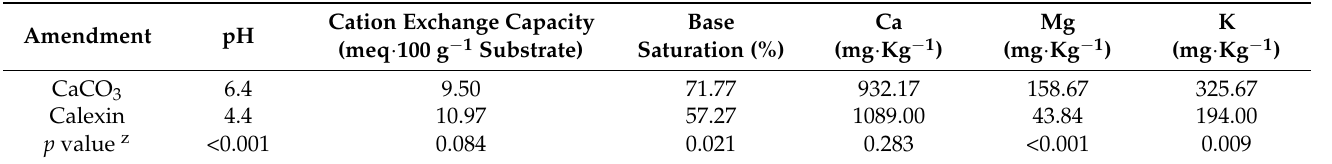
Table 1. Substrate characteristics before transplant. A substrate composed of a 3:1 mixture of coconut coir and per- lite was amended with CaCO 3 or a Ca-containing fertilizer (Calexin) 7 days before transplanting ‘Emerald’ southern highbush blueberry.